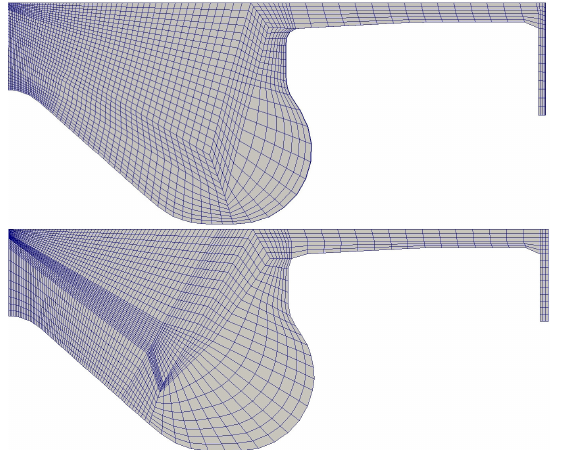
Figure 7. Comparison between mesh manually tuned used for the validation cases ( upper one ) and automatically generated ( bottom one ).